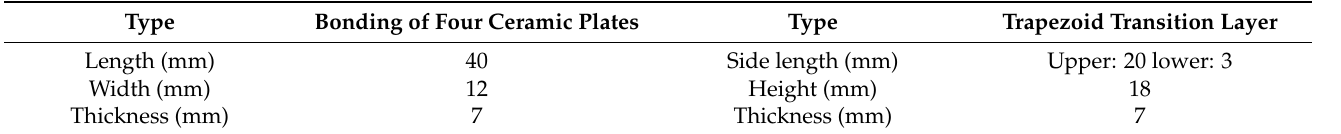
Table 2. Size parameters of piezoelectric oscillator.